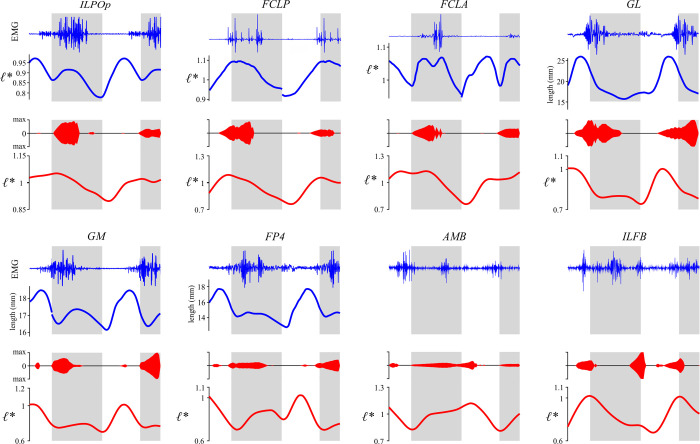
Comparison of exemplar outputs for excitation and fibre length change in the running simulation against previous experimental data (electromyography and sonomicrometry), for validation of the modelling and simulation approach.For each muscle, experimental data are shown in blue, and simulation outputs are shown in red; in some studies sonomicrometry data were reported in absolute terms, whereas in others it was reported in relative terms. See Table 2 for muscle abbreviations. Fibre length data do not exist for the AMB or ILFB. Experimental results were digitized from the original studies and scaled according to swing and stance phase durations. Sources of experimental data are as follows: ILPOp, guineafowl running at 2.5 m/s [9]; FCLP and FCLA, guineafowl running at 1.5 m/s [38]; GL, guineafowl running at 1.3 m/s [36]; GM, guineafowl running at 2 m/s [141]; FP4, guineafowl running at 1.3 m/s [36]; AMB and ILFB, guineafowl running at 1 m/s [27].